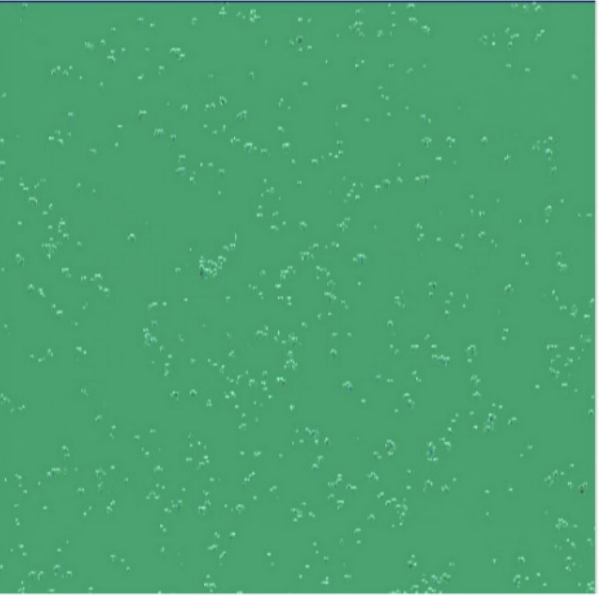
Figure 8. Surface profile after the application of Gaussian filter of the uncoated-intact samples.